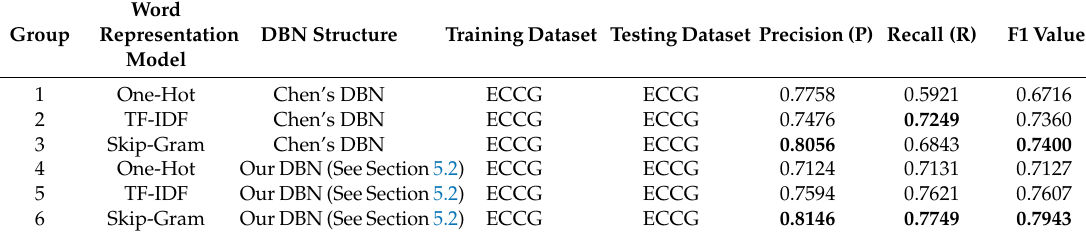
Table 2. Toponym recognition results of different word representation models on different datasets.